Question: Which visualization type does this figure use?
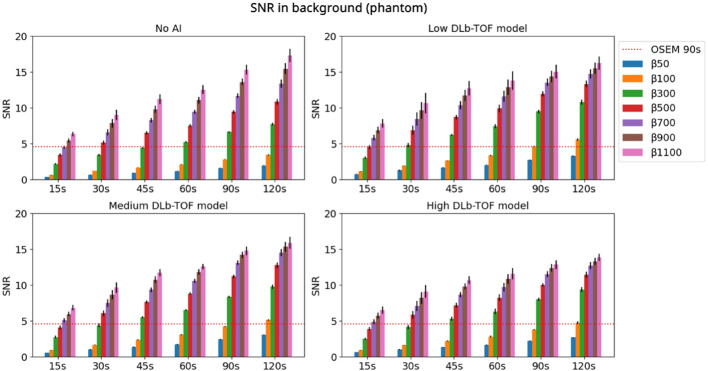
Answer: bar